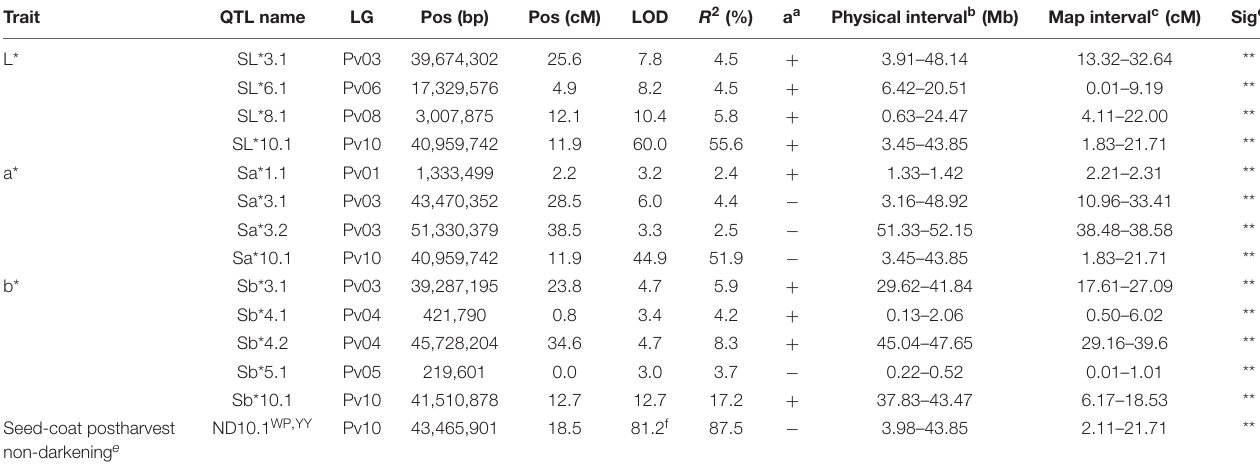
TABLE 5 | Quantitative trait loci identified in the RIL population ( N = 242) using BLUPs from samples grown in Entrican, MI in 2017 for color and seed-coat postharvest non-darkening. Trait